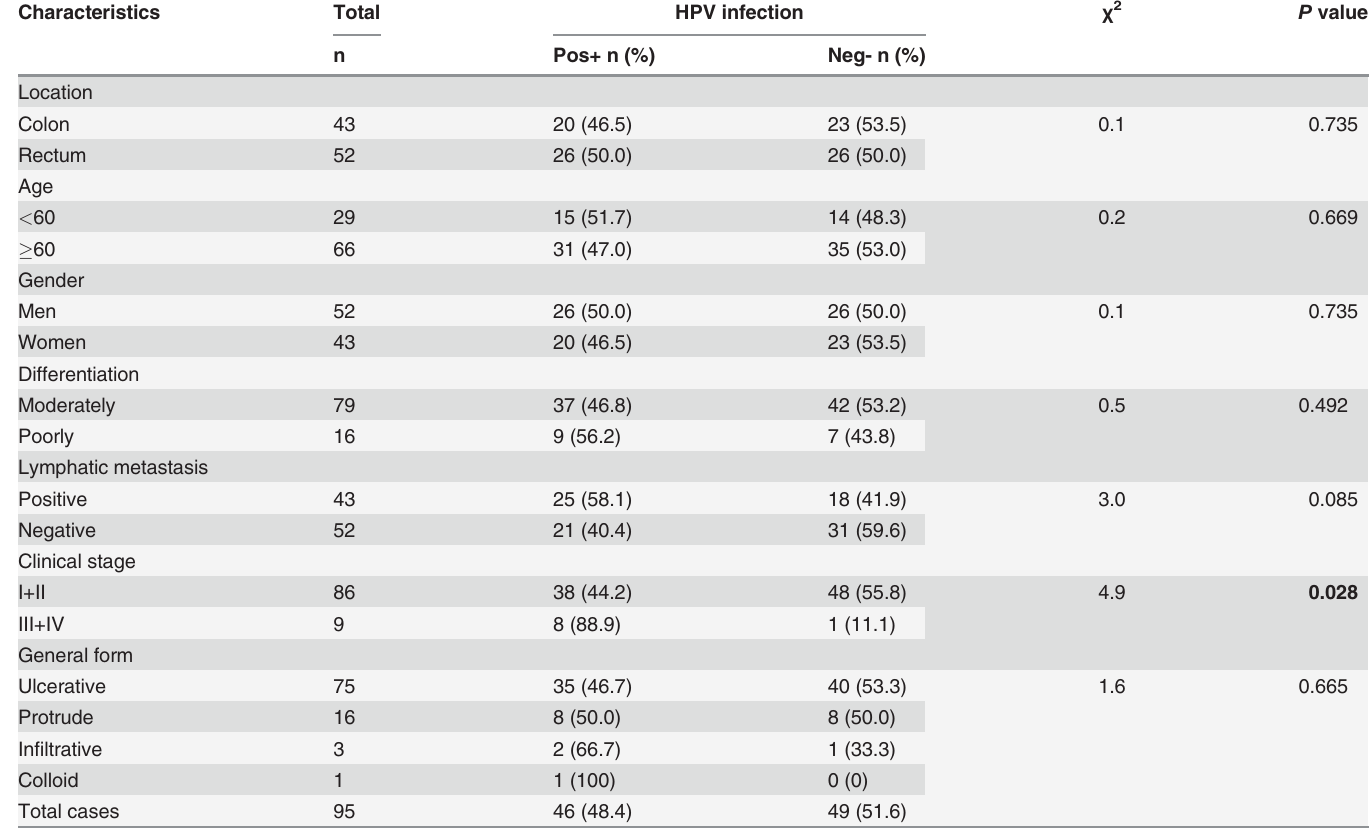
Table 3. HPV Infection Only Correlates with Late Clinical Stages among Many Clinicopathological Characteristics of CRC. Characteristics